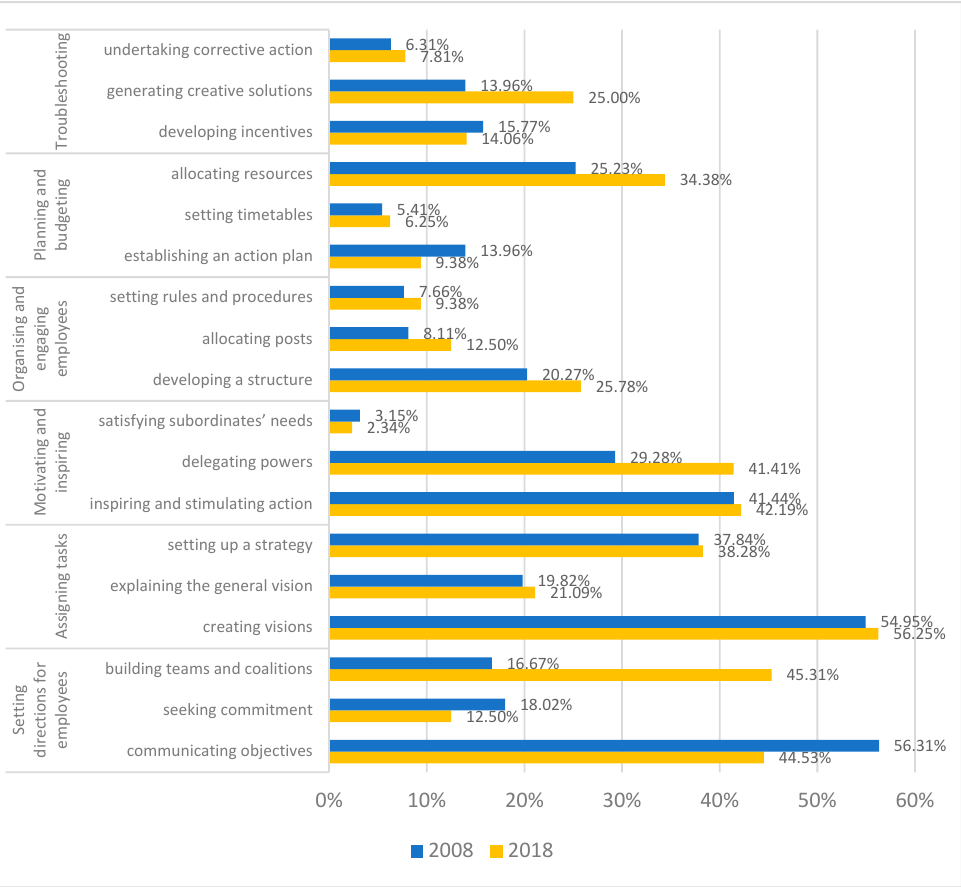
Figure 6. Evaluation of the importance of the top management activity areas by leaders of the Forbes Global 2000 world’s largest corporations.